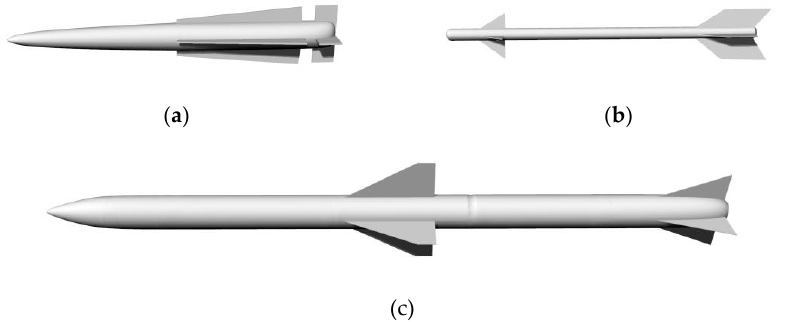
Figure 11. The geometries of different types of missile−like targets: ( a ) Type 1; ( b ) Type 2; ( c ) Type 3.